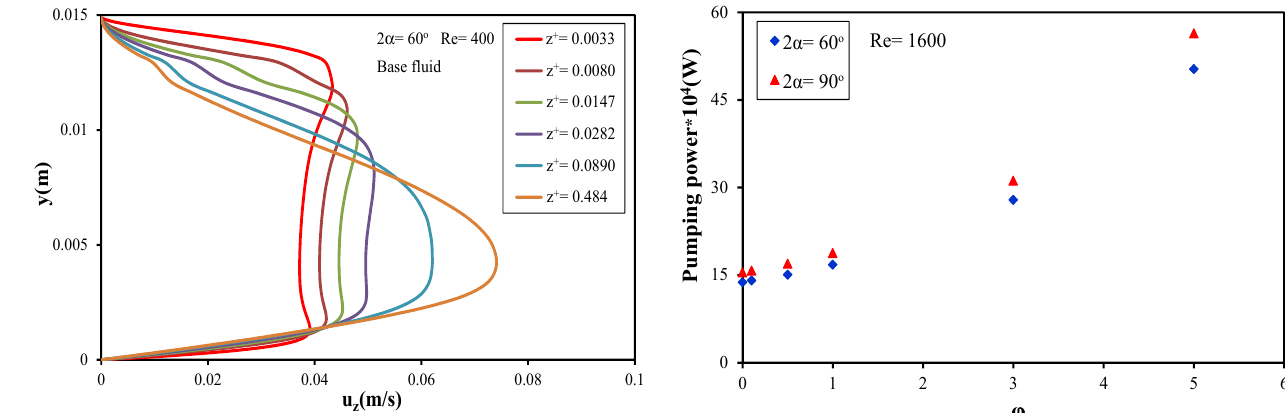
Fig. 11. Pumping power of fluids vs. nanoparticle concentration in the two apex